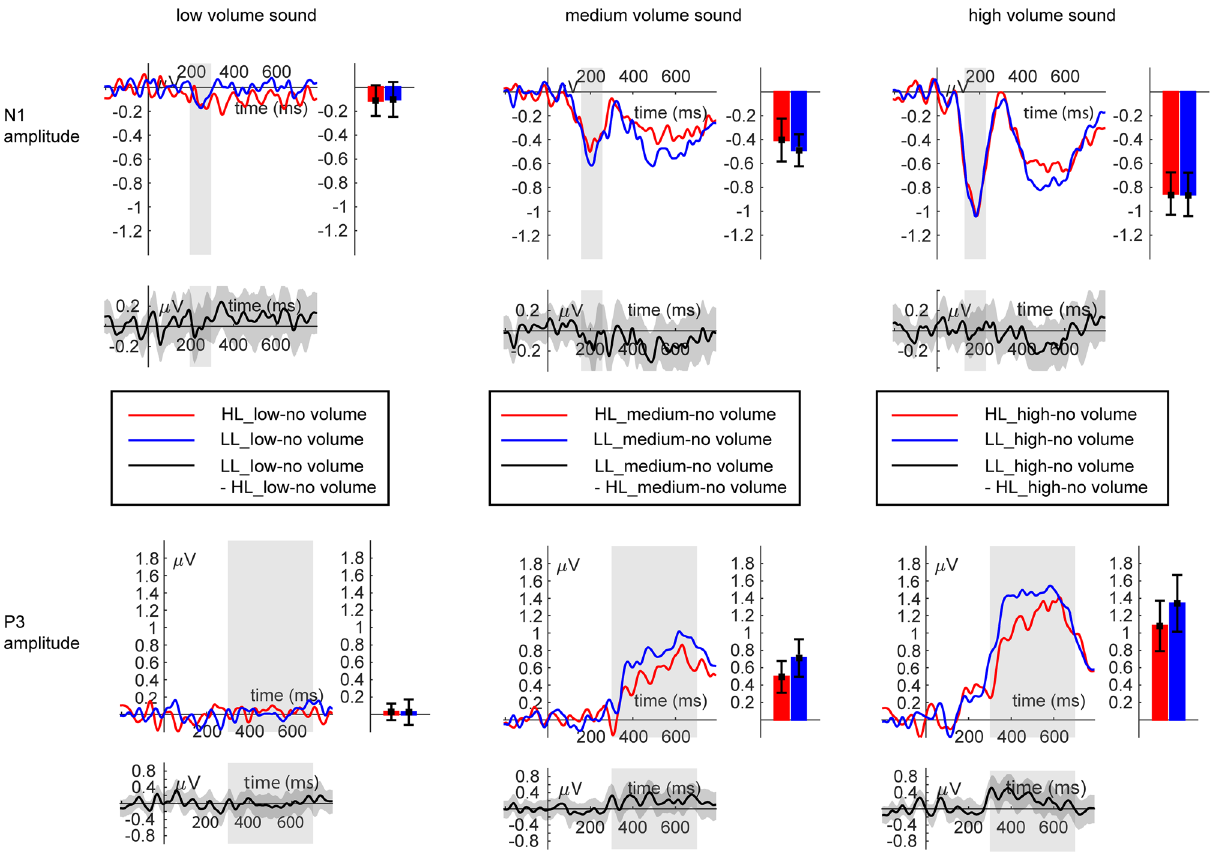
Figure 6. ERPs ( n = 43) for the two load conditions (LL, HL) and the three sound volume conditions (low, medium, high) in the N1 time range (top row) and the P3 time range (bottom row).